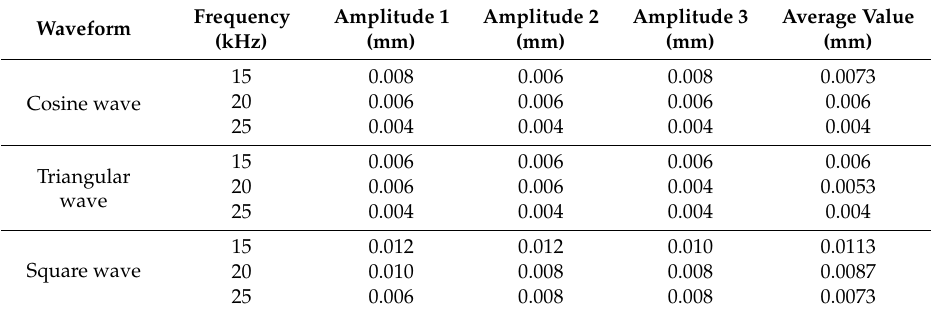
Table 3. The vibration amplitude of the ultrasonic transducer under different waveform and